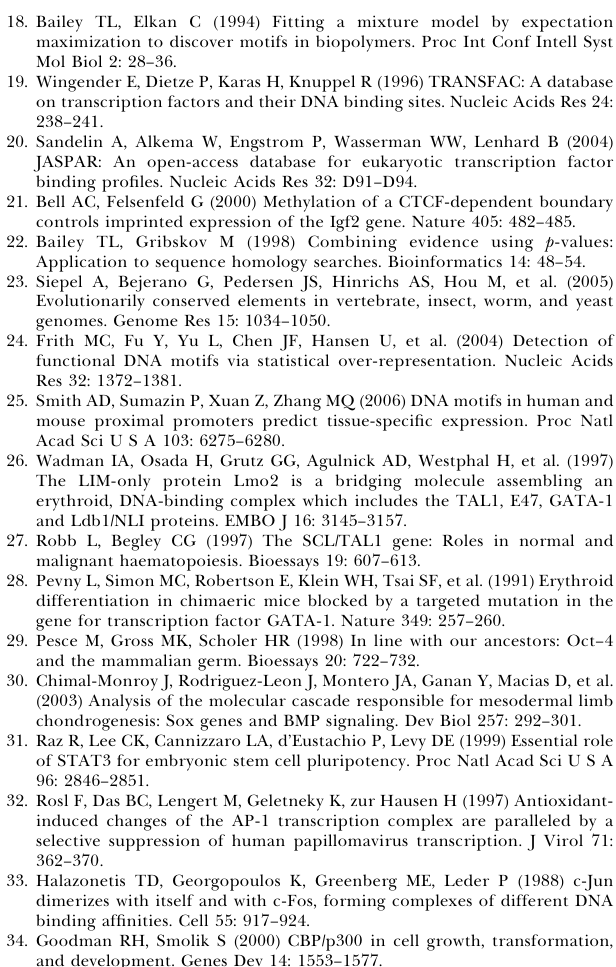
Table S1. The 26 Ubiquitous Distal DNaseI HS That Overlap CTCF ChIP-Chip Hits